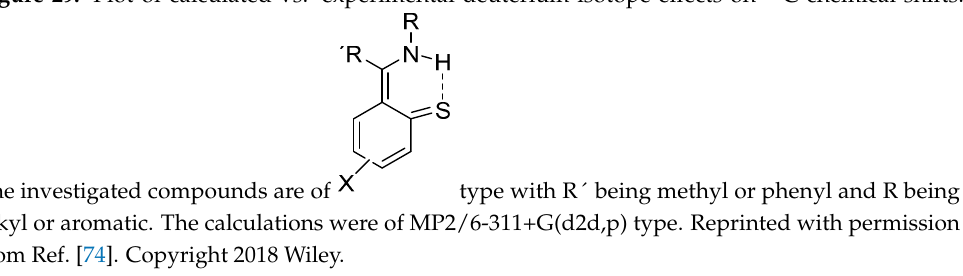
The investigated compounds are of type with R ´ being methyl or phenyl and R being alkyl or aromatic. The calculations were of MP2/6-311+G(d2d,p) type. Reprinted with permission from Ref. [74]. Copyright 2018 Wiley.